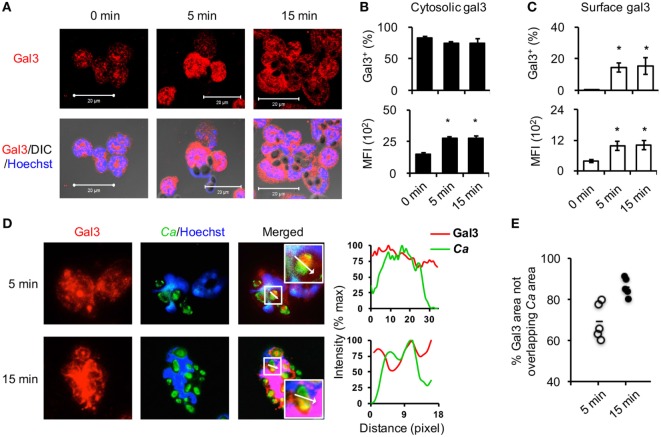
Opsonized Candida upregulates cytosolic gal3 expression in neutrophils. Bone marrow neutrophils were stimulated with opsonized Candida SC5314 (A–C) or GFP+ OG1 (D,E) for 5 or 15 min. Zero minutes represent unstimulated cell controls incubated in serum-containing medium for 15 min. (A) Cells were cytospun, permeabilized, and stained for gal3 (red) and nucleus (blue) before confocal microscopic analysis for gal3 expression. DIC, differential interference contrast. (B,C) Neutrophils were stained with rat anti-gal3 and PE-goat anti-rat antibodies, fixed in 4% PFA, permeabilized, and then stained with Alexa 647-rat anti-gal3 antibody. The % of cells expressing cytosolic gal3+
(B) and surface gal3+
(C) in total cell population are shown in upper panels. The levels of cytosolic (B) and surface gal3 (C) expression are shown as mean fluorescence intensity (MFI) in lower panels. Data are presented as mean ± SD. *p < 0.05, as analyzed by Mann–Whitney test. n = 3. (D,E) Neutrophils were allowed to ingest GFP+ OG1 Candida (green) and stained for gal3 (red) and nucleus (blue) before subjecting to fluorescence microscopic analysis. (D) The intensity of fluorochromes along the white arrow in the merged image is shown in the histogram on the right. (E) The % of gal3+ area (red) that is not overlapped with Candida (green) in the whole gal3+ area (red) (180,760 µm2 in average) at 5 and 15 min after encounter was analyzed by Metamorph software. Each dot represents one photo image. n = 5.